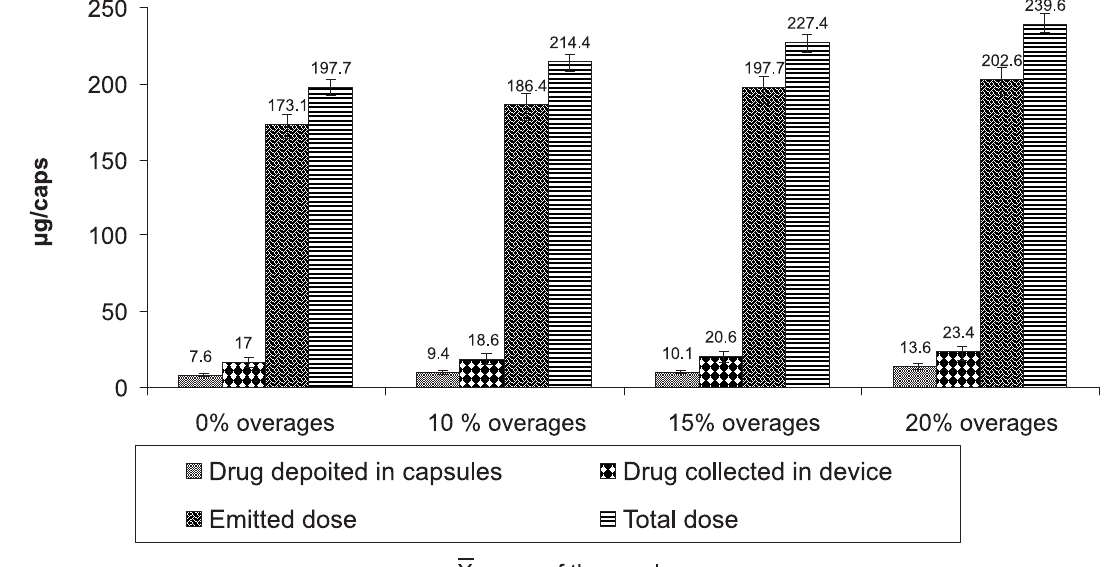
FIGURE 1 - Histograms correlating emitted dose and overages of beclomethasone dipropionate DPI 200 µg.